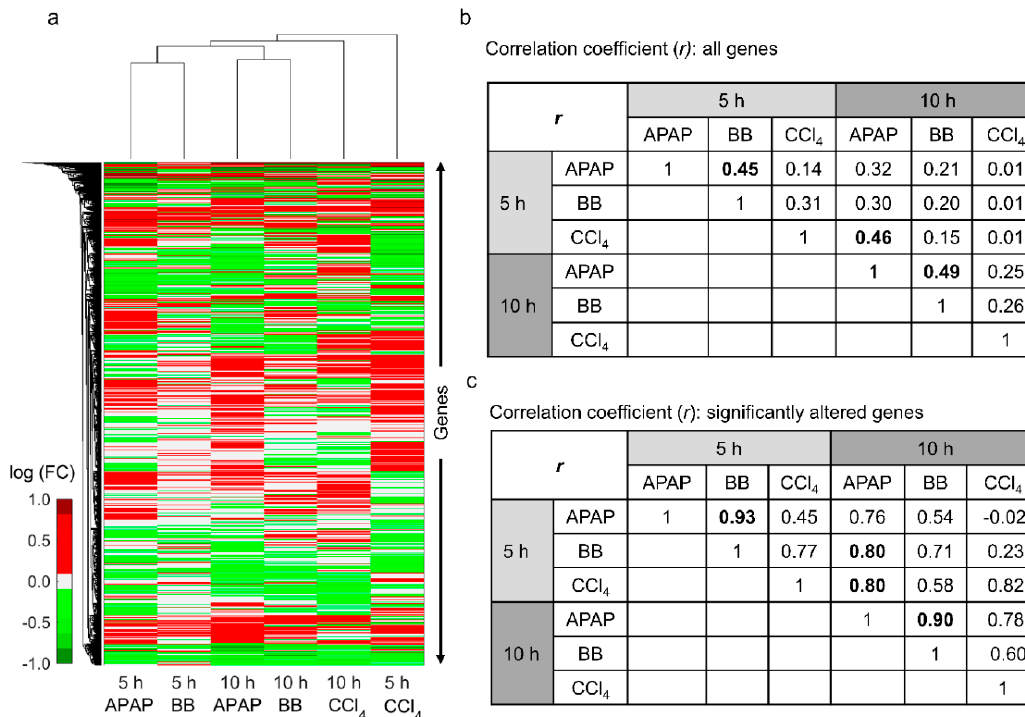
Figure 2. Identification of commonalities in liver gene expression changes from rats exposed to either APAP, BB, or CCl 4 . ( a ) Hierarchical clustering analysis of all common genes in the rat liver at 5 and 10 h after exposure of the toxicant. Red and green bars indicate up- and down-regulated genes, respectively; grey bars indicate unchanged genes. Pairwise correlation of the natural logarithmic fold changes (log(FC)) in genes common between the two toxicants ( b ) without using any significance cut-off values and ( c ) with using only significantly altered genes (false discovery rate (FDR) < 0.1). Pairwise combinations with high correlation coefficient values are indicated in bold.